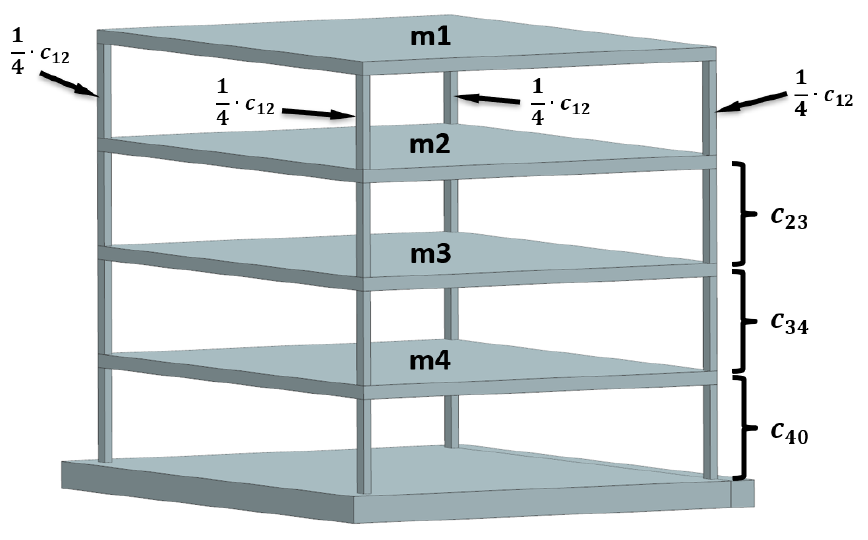
Figure 6. 3D model of the tested system.